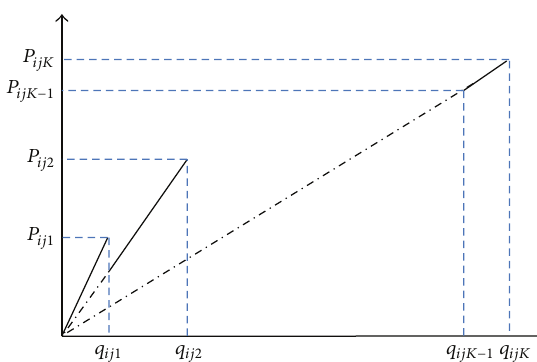
Figure 2: AUD policy for purchasing the products in different periods.